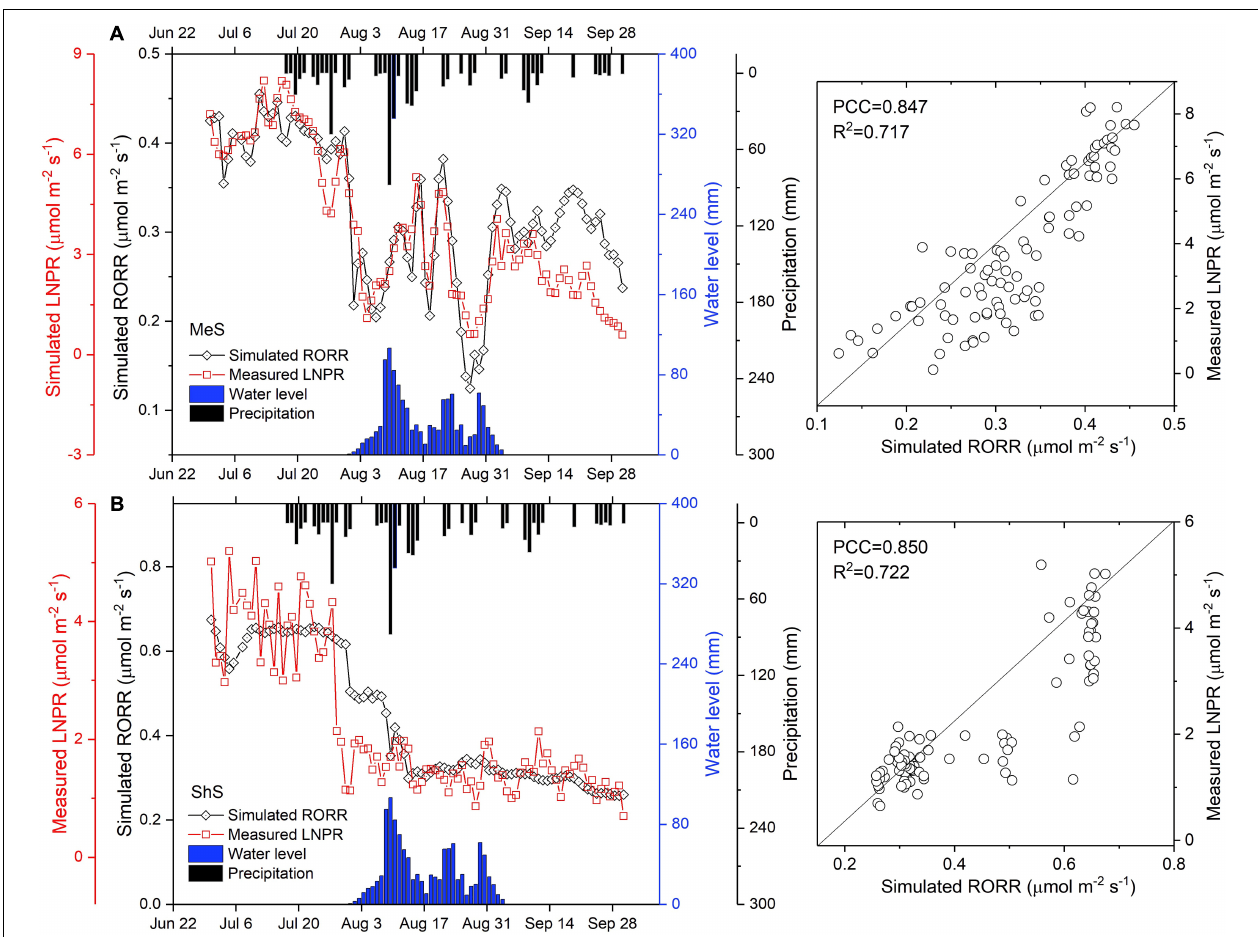
FIGURE 4 | Simulated root oxygen respiration rate (RORR) and measured leaf net photosynthesis rate (LNPR) of the MeS (A) and ShS (B) under the influence of rainfall and surface water level. Scatter tracks demonstrate the relationship between the observed and simulated values of the MeS and ShS by displaying Pearson Correlations Coefficients (PCC) and the determination coefficient ( R 2